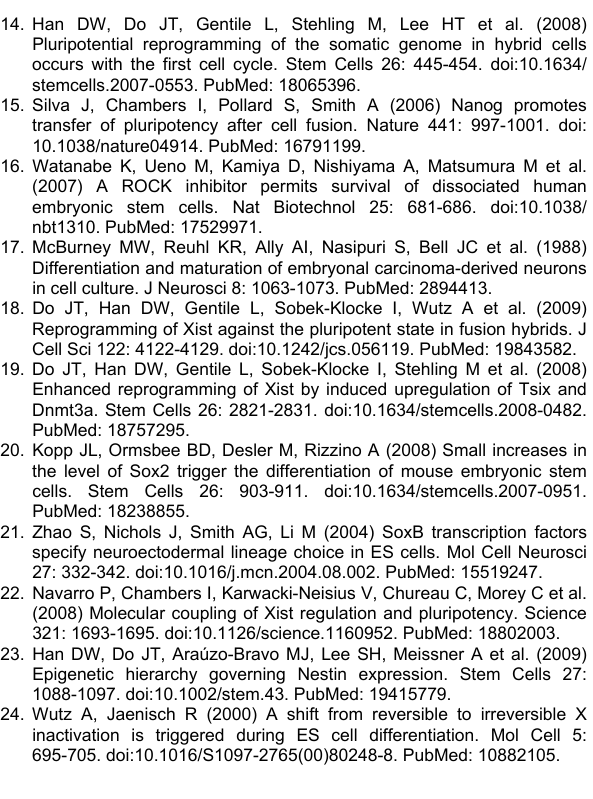
Figure S1. Overexpressing Sox2 in P19 ECCs. ( A ) The expression levels of Oct4 , Nanog , and Sox2 were compared in three different cell lines: ESCs, F9 ECCs, and P19 ECCs. ( B ) Sox2 expression was analyzed after transduction of different amount of viruses into P19 ECCs. ( C ) Comparison of the morphology of P19 ECCs (non-infected) and P19- Sox2 cell lines (clone 1~3).